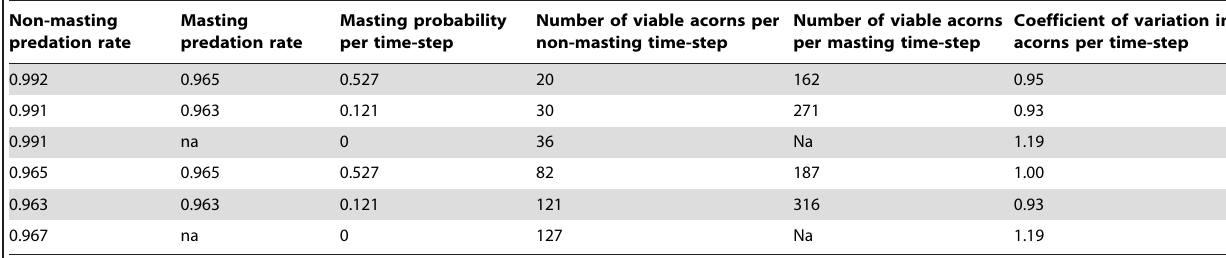
Table 1. Six masting-predation